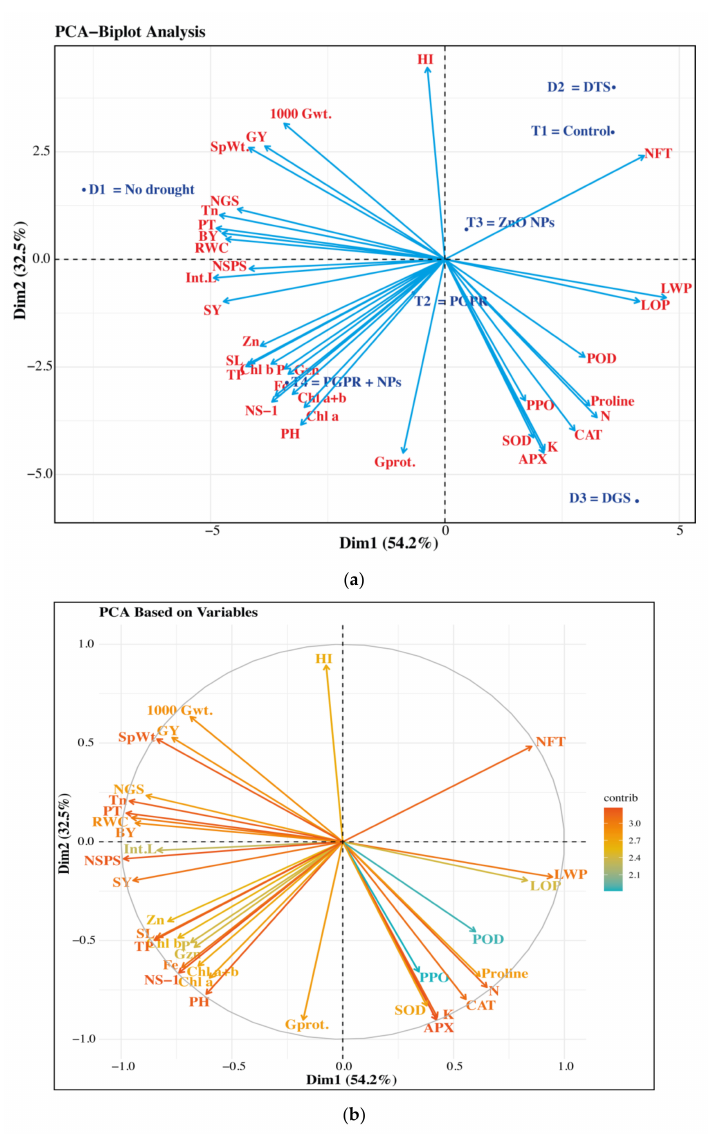
Figure 8. ( a ) The Principal Component Analysis (PCA) was based on different parameters of wheat under different treatments of Azospirillum brasilense , ZnO NPs, and drought stress. (b) The PCA